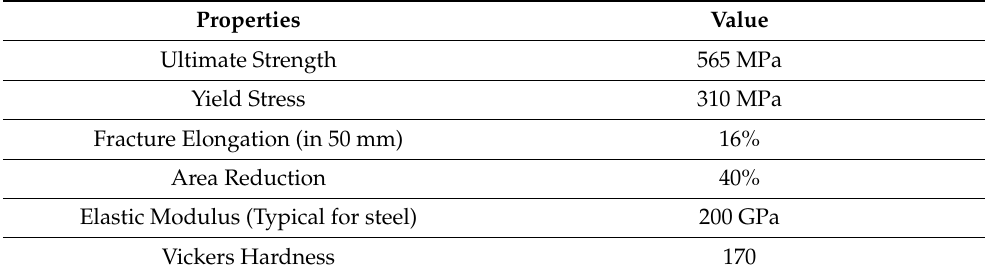
Table 2. Mechanical properties of AISI 1045 steel alloy